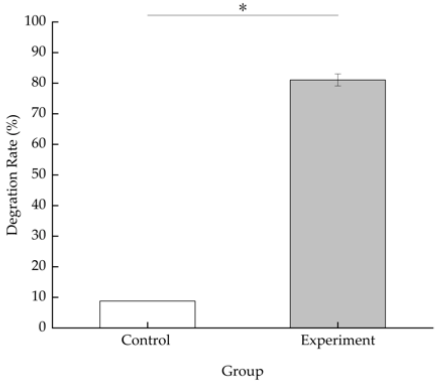
Figure 5. Degradation efficiency of BDE-209 by strain TAW-CT127 at 3 g/L (wet weight), 28 °C, pH 7.4 ± 0.2, 160 rpm for 5 d, *: p < 0.05.